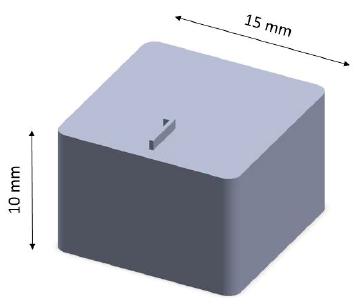
Figure 2. Example of cubic samples produced for the parameter optimization.